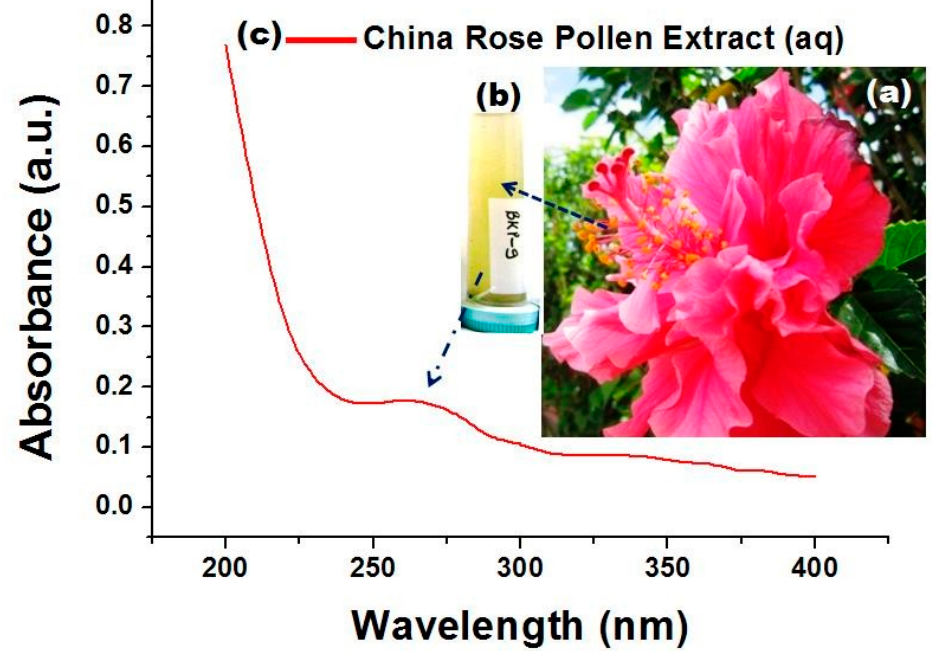
Figure 1. ( a ) Photographic image of double-petal China rose/ Hibiscus rosa-sinensis flower, ( b ) its pollen extract, and ( c ) UV–vis spectrum of its pollen extract.